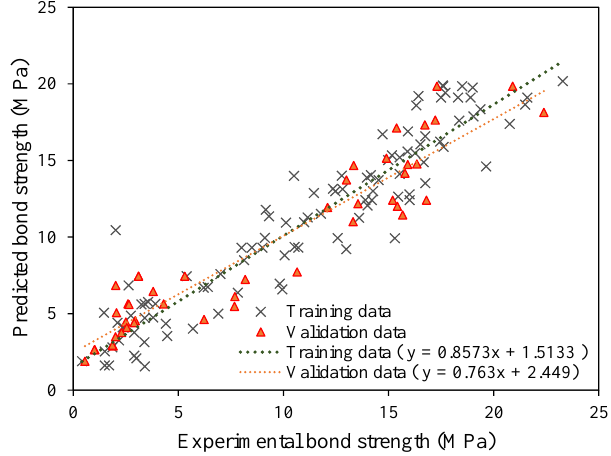
Figure 5. Comparison of the regression slopes for the training and validation data of the optimised trial No. 10.